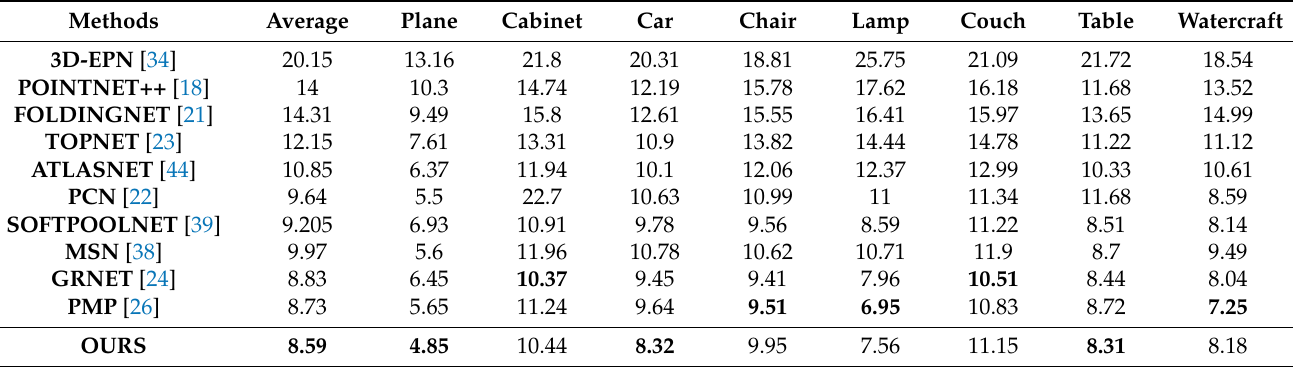
Table 1. Point completion results on PCN dataset in terms of per-point chamfer distance (CD) with L1 norm computed on 16,384 points and multiplied by 10 3 . The best results are highlighted in bold (lower is better).